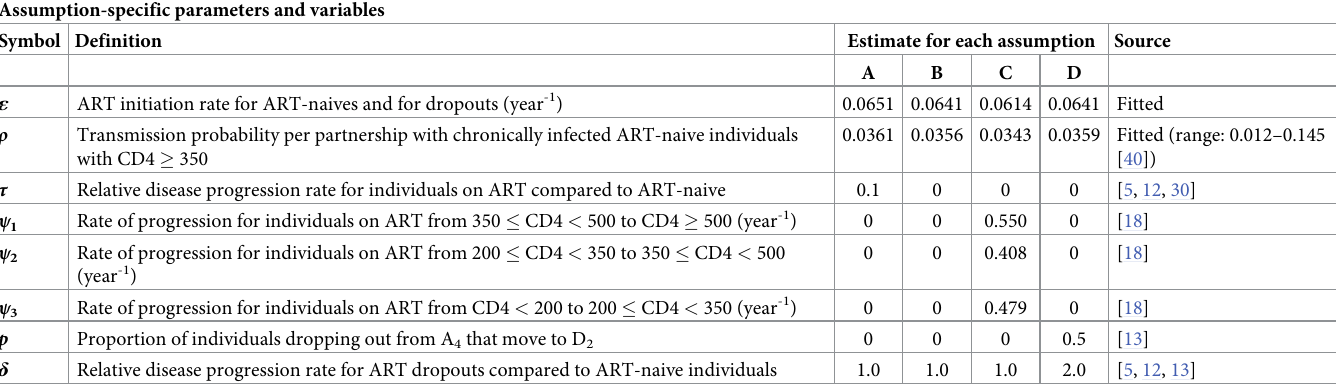
Table 2. Assumption-specific parameter symbols, definitions, baseline values, and